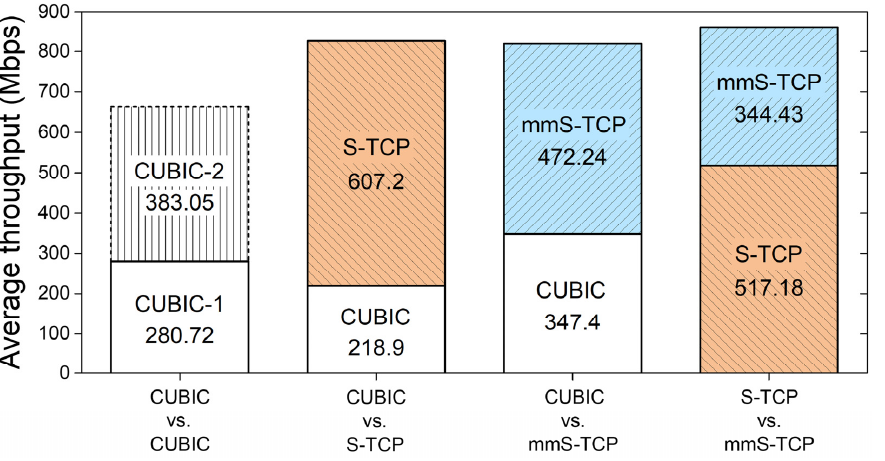
Figure 12. Average throughput of each flow when they compete.